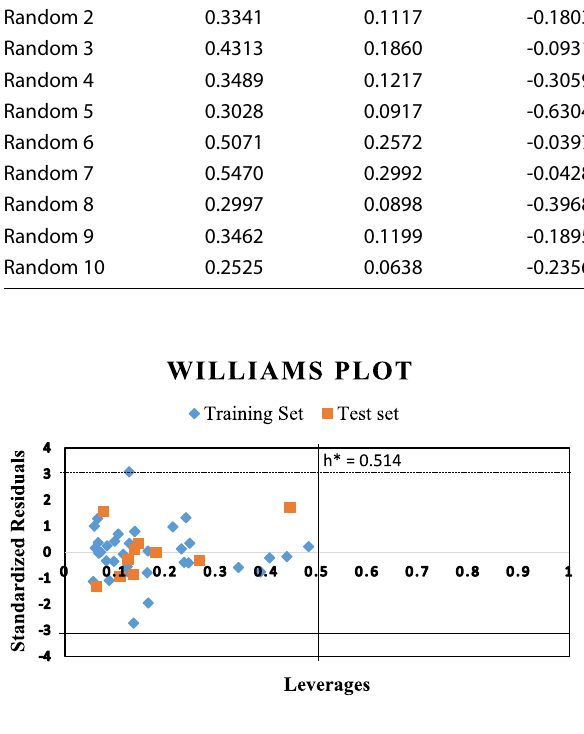
Fig. 2 The graph of standardized residuals of the data set against their leverage